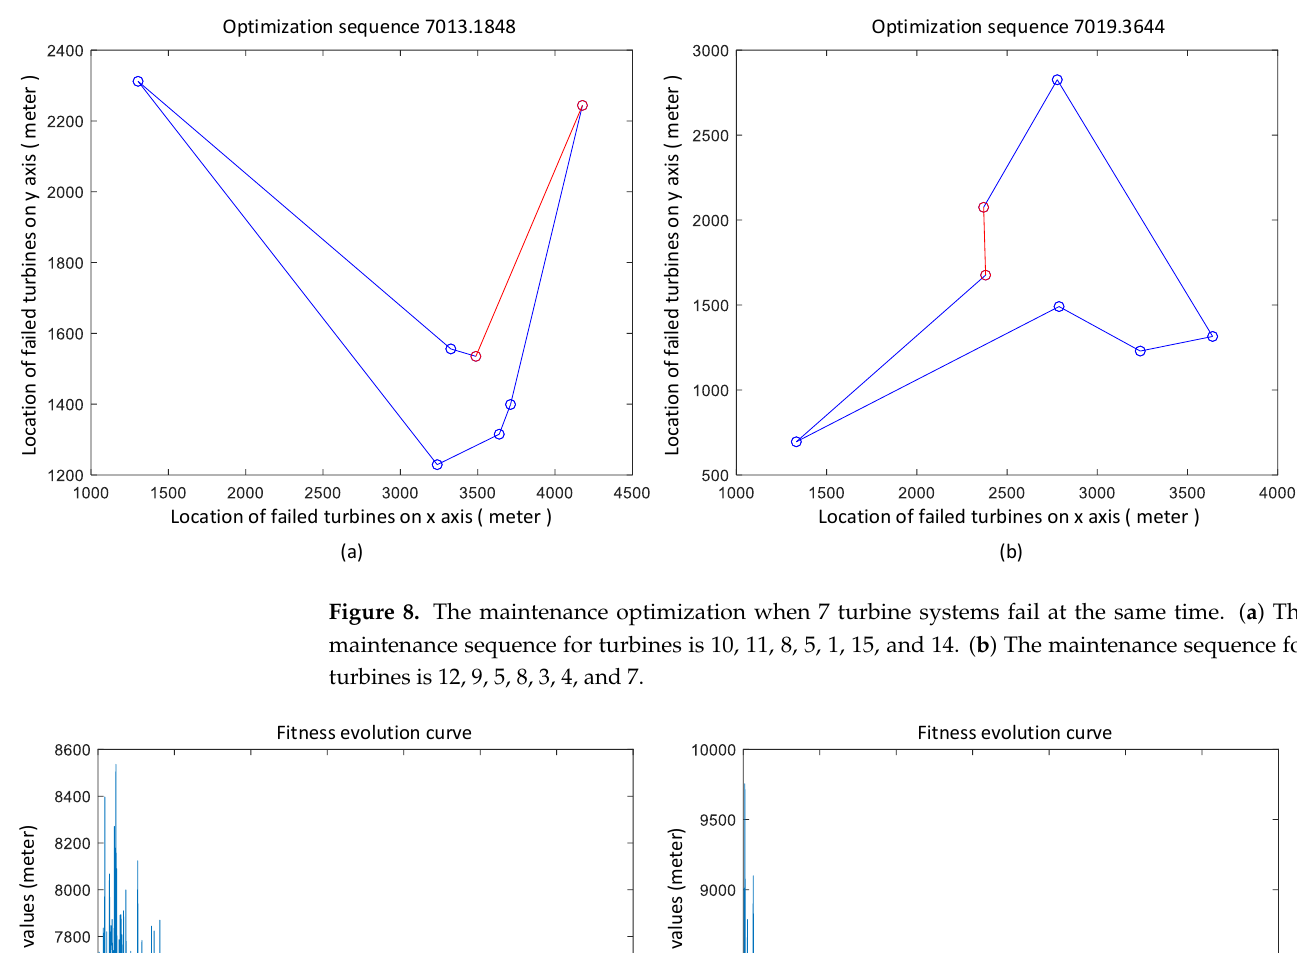
Figure 7. The dynamic grouping failure modes of 18 turbine systems .